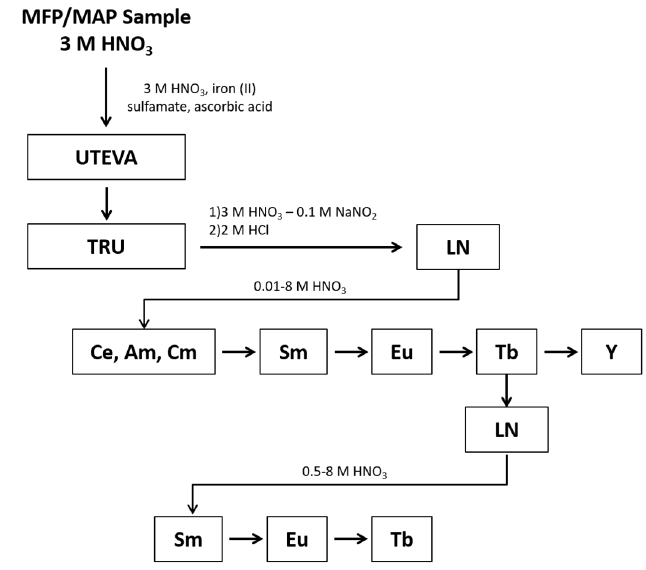
Figure 1. The separation of the lanthanides, Y, and tri-valent actinides from a mixed fission/mixed activation product sample of irradiated HEU. Table 3. Chemical yields for the separated lanthanide fractions sent for radiometric detection (gamma spectroscopy or LEPS). Samples were run in